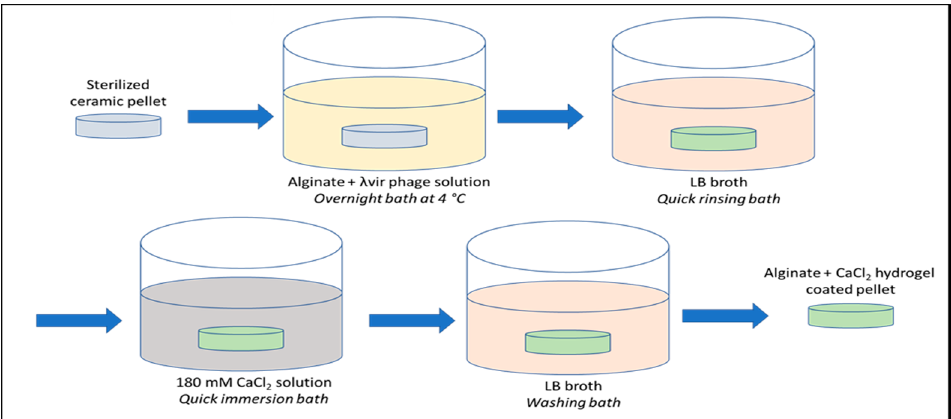
Figure 5. Schematic diagram of alginate–CaCl 2 -hydrogel-coated pellet